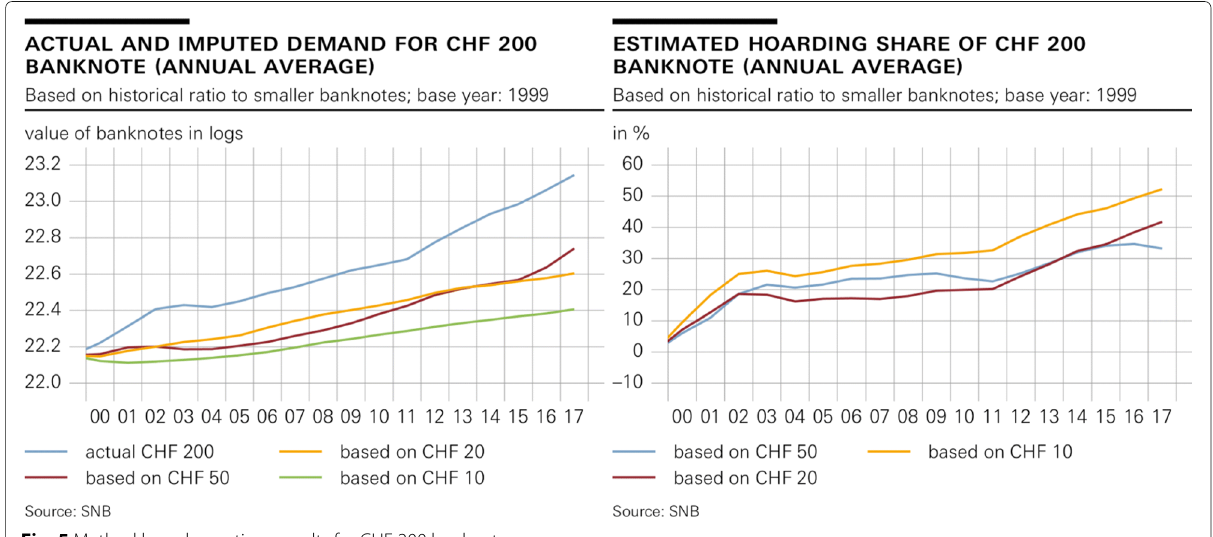
the Swiss wealth tax. 31 This motivates the aforementioned use of the January to February seasonal range for the CHF 1000 banknote. As bank statements issued for tax purposes show only the balance on December 31, giv- ing an incentive to withdraw cash right before the end of December, end-of-month cash figures might be distorted for this reason. Most likely, the cash then is redeposited again until the end of January that features the second largest seasonal